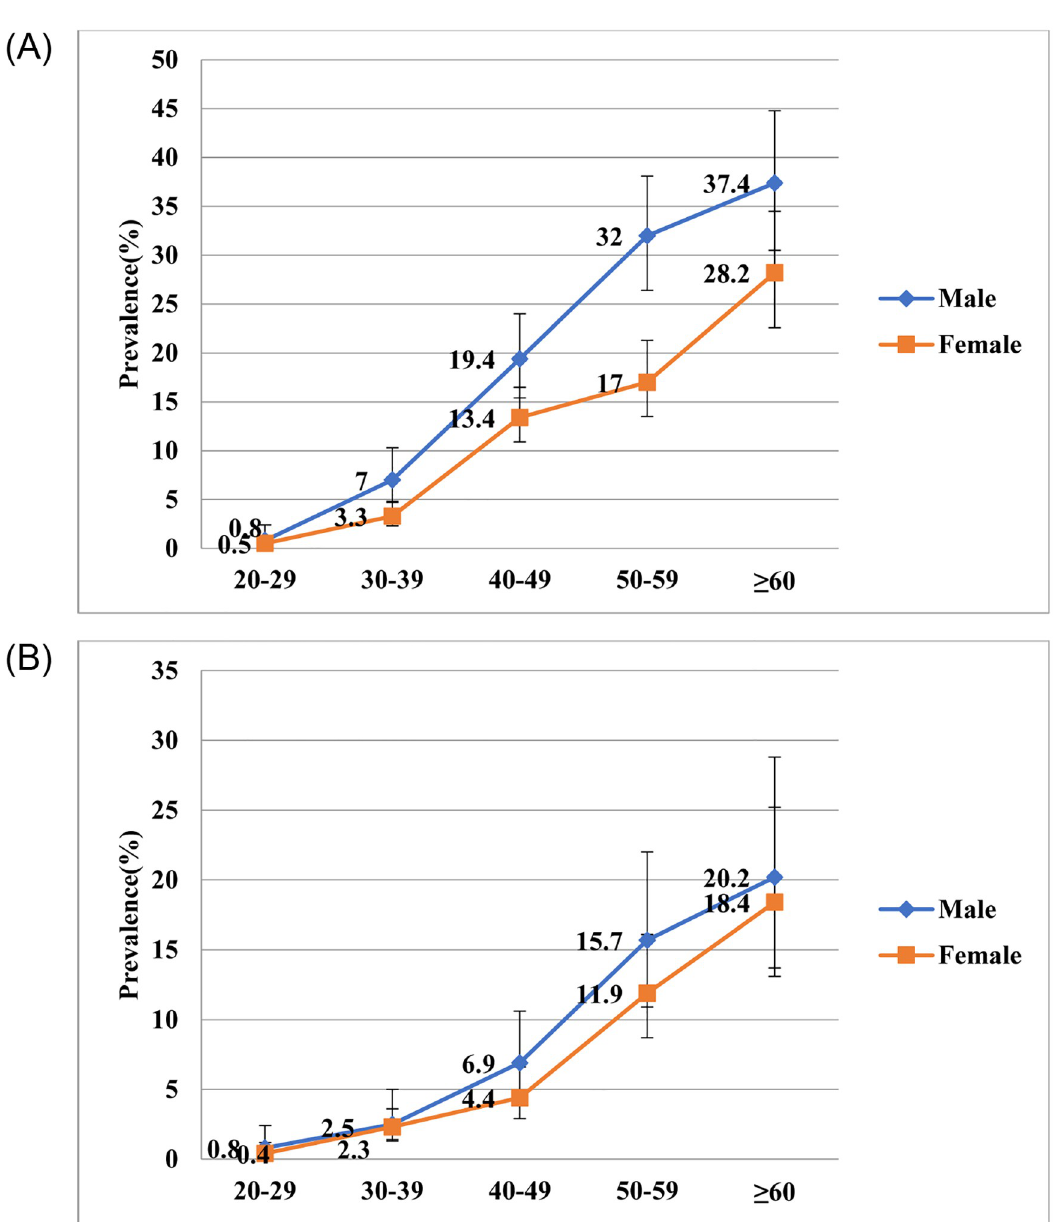
Fig 2. A: Age specific prevalence of diabetes from year 2001–2017. B: Age specific prevalence of pre-diabetes from year 2001–2017.